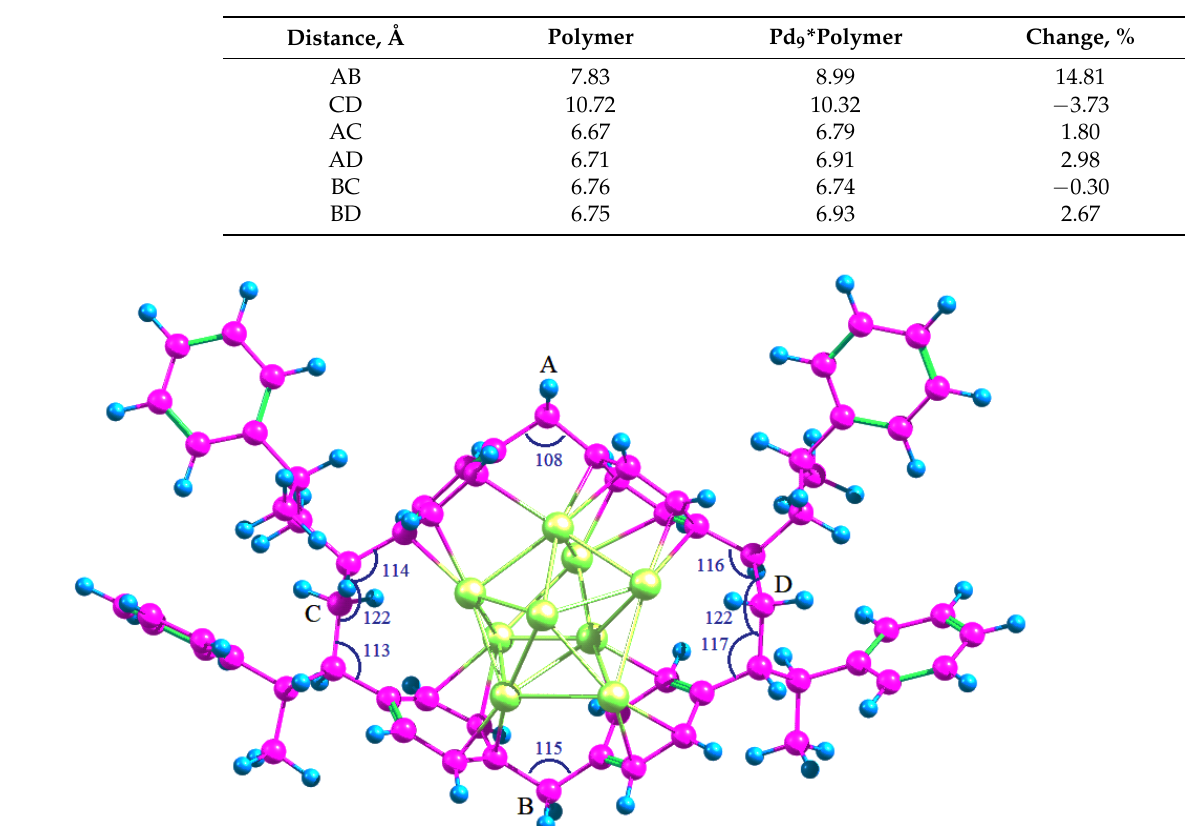
Figure 5. Optimized geometry of Pd 9 incorporated into the HPS micropore.